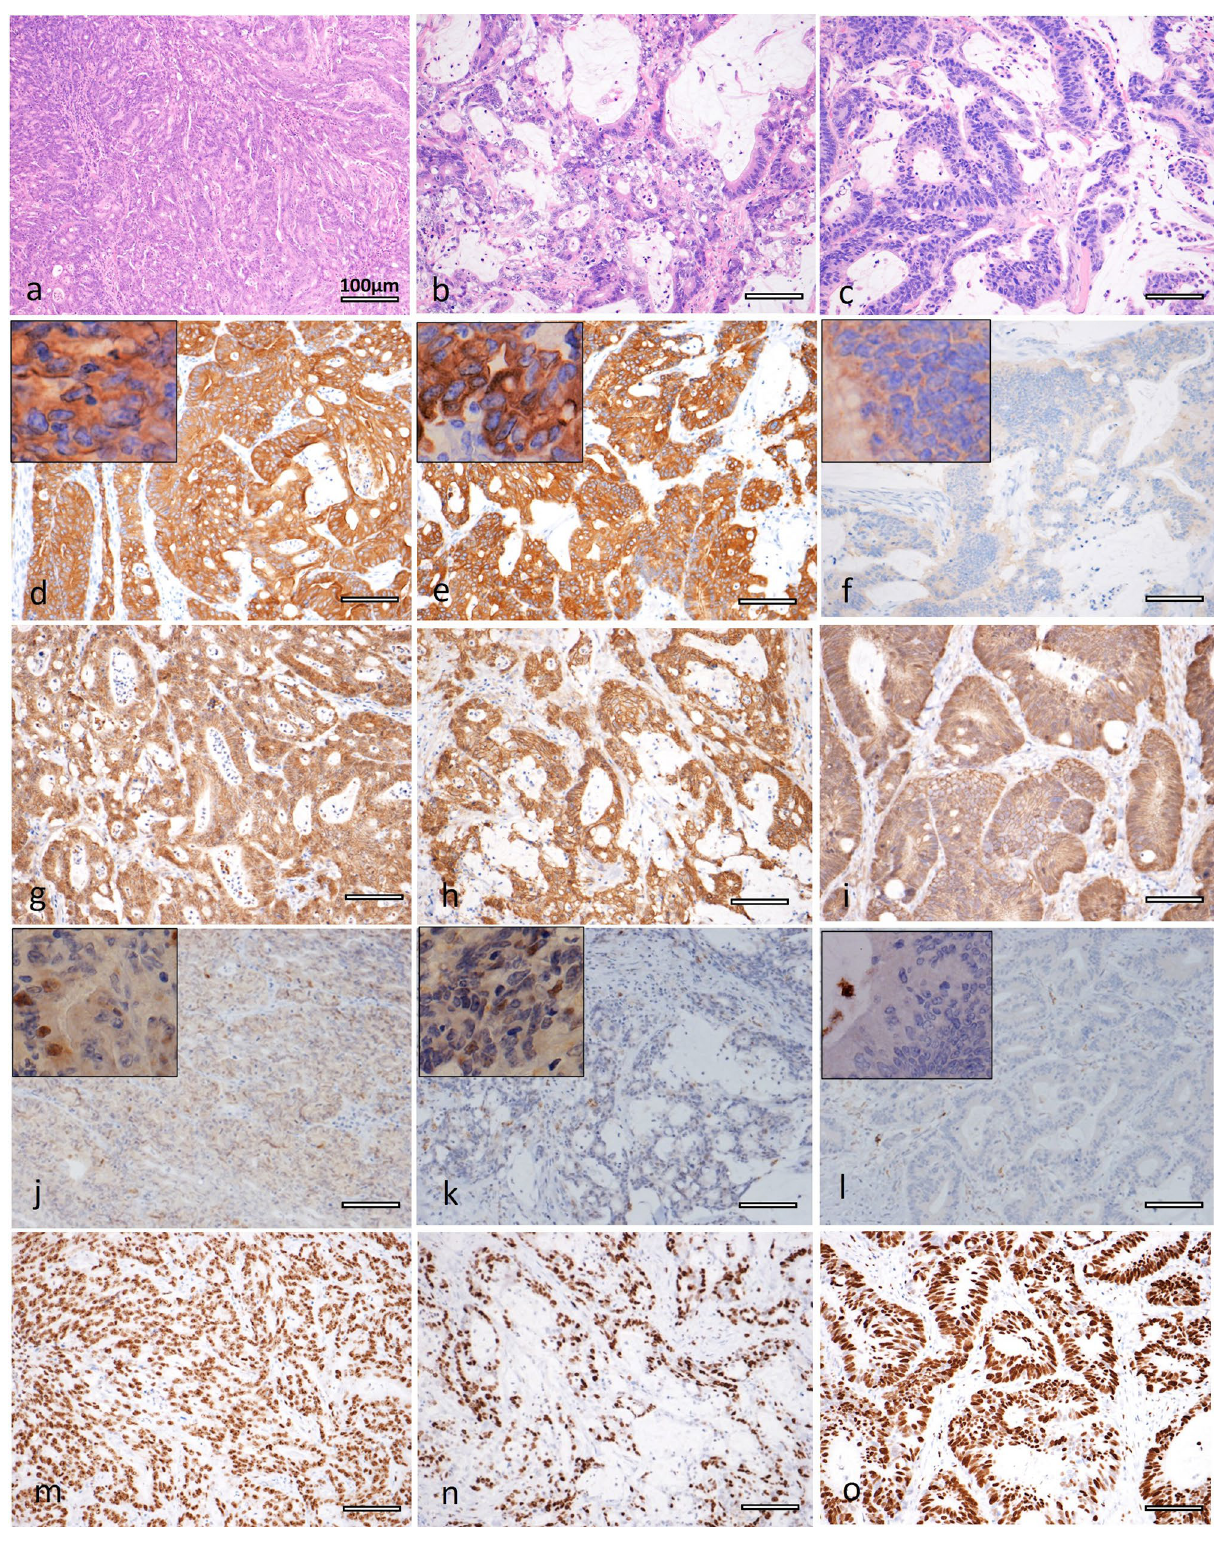
Figure 1. ( a – o ) Histological feature of Case #1 showing adenocarcinoma with a solid pattern ( a ). Histology of Case #2 showing mucinous carcinoma with a focal solid area ( b ). Histology of Case #3 showing moderately differentiated adenocarcinoma with a focal mucinous area ( c ). Pan-trk IHC images showing diffuse cytoplasmic and membranous staining for Case #1 ( d ) and Case #2 ( e ), while weak but diffuse cytoplasmic staining can be seen for Case #3 ( f ). Insets show higher magnifications. All three cases showed β-catenin membranous staining without nuclear staining (Case #1: ( g ); Case #2: ( h ); Case #3: ( i ). p53 of Case #1 ( j ) and Case #2 ( k ) showing wild type pattern, Case #3 showing completely absent pattern ( l ). Insets show higher magnifications. MIB-1 LI was high in all cases, with levels of approximately 80% in Case #1 ( m ), 50% in Case #2 ( n ) and 75% in Case #3 ( o